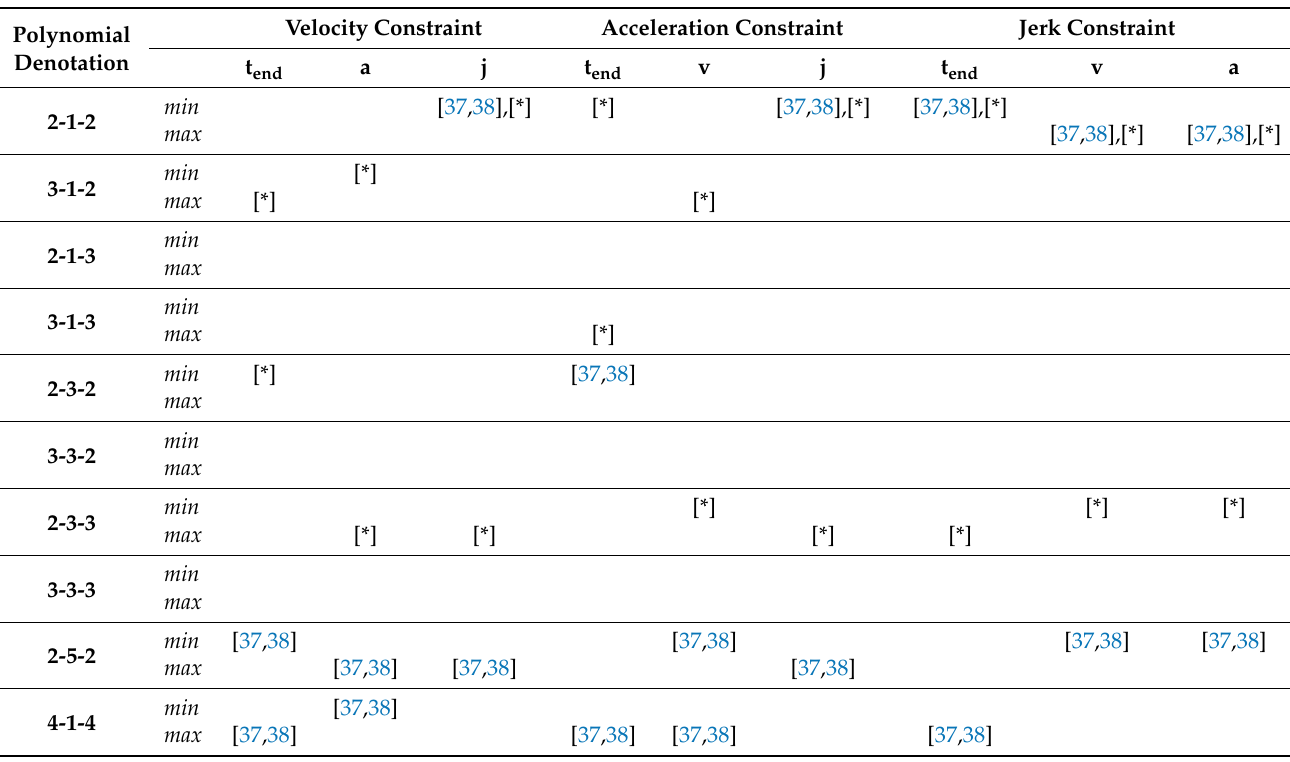
Table 4. Literature references on the occurrence of extreme kinematic parameters for polynomial profiles with